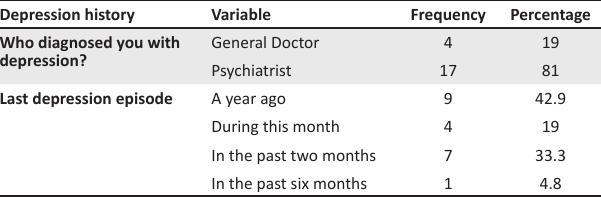
TABLE 2: Depression History of the depressed